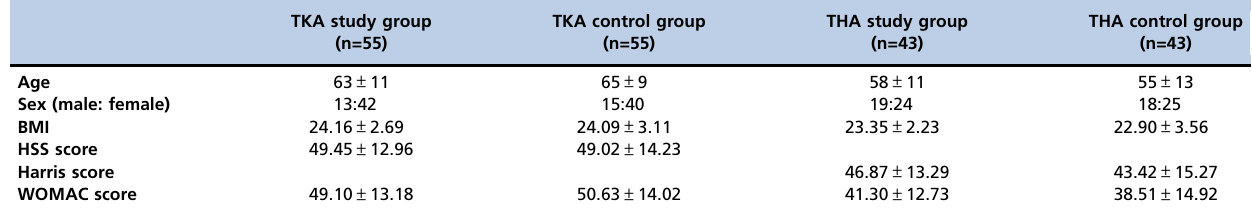
Table 1 - Demographic data for patients in the study.